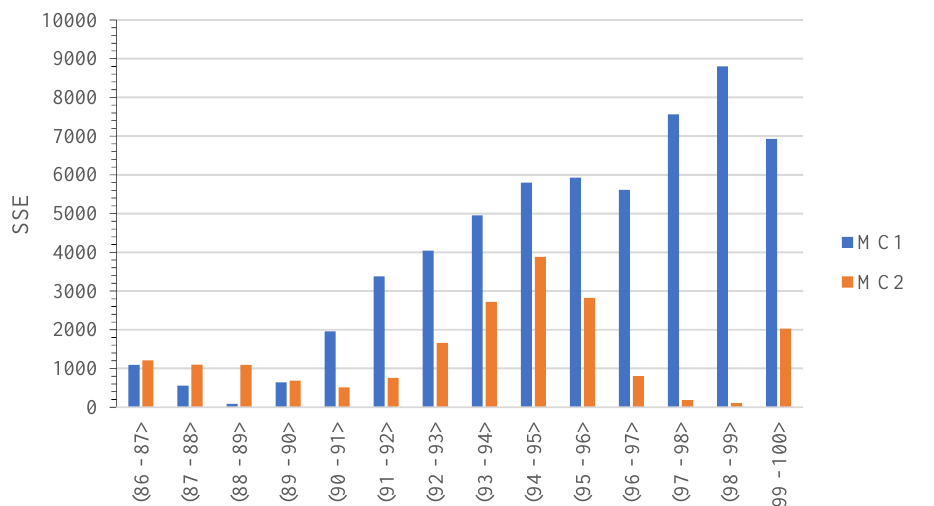
Figure 6. Change in the SSE value of MC1 and MC2, in 1 mm intervals.